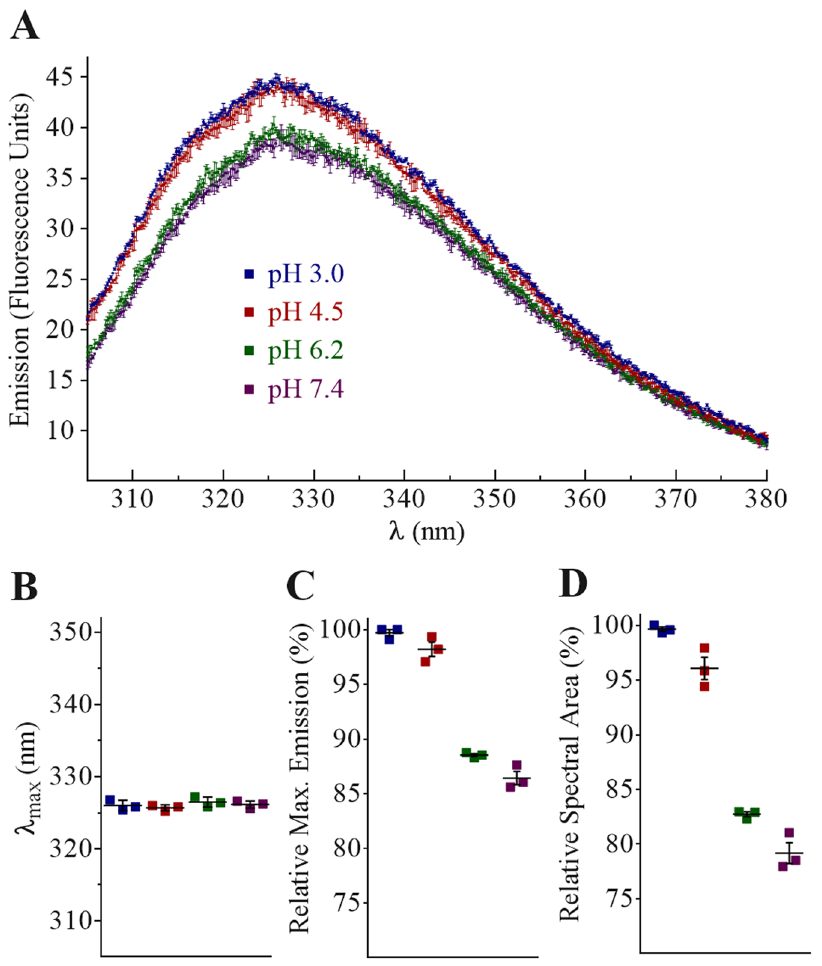
Figure 3. Intrinsic Trp fluorescence emission. ( A ) Solution intrinsic Trp fluorescence emission of StAP PSI at pH 3.0, 4.5, 6.2, and 7.4. ( B ) λ max at the indicated pH values were not significantly different comparing all respective pairings (P > 0.05). ( C ) Relative maximum fluorescence emission was not significantly different (P > 0.05) between pH 3.0 and 4.5, nor pH 6.2 and 7.4 (P > 0.05), whereas each of the former pair were significantly different (P ≤ 0.05) from the latter pair, respectively. ( D ) Relative areas under the emission spectra (305–380 nm) were significantly different (P ≤ 0.05) for all data set pairings (mean + / − one standard deviation, n =